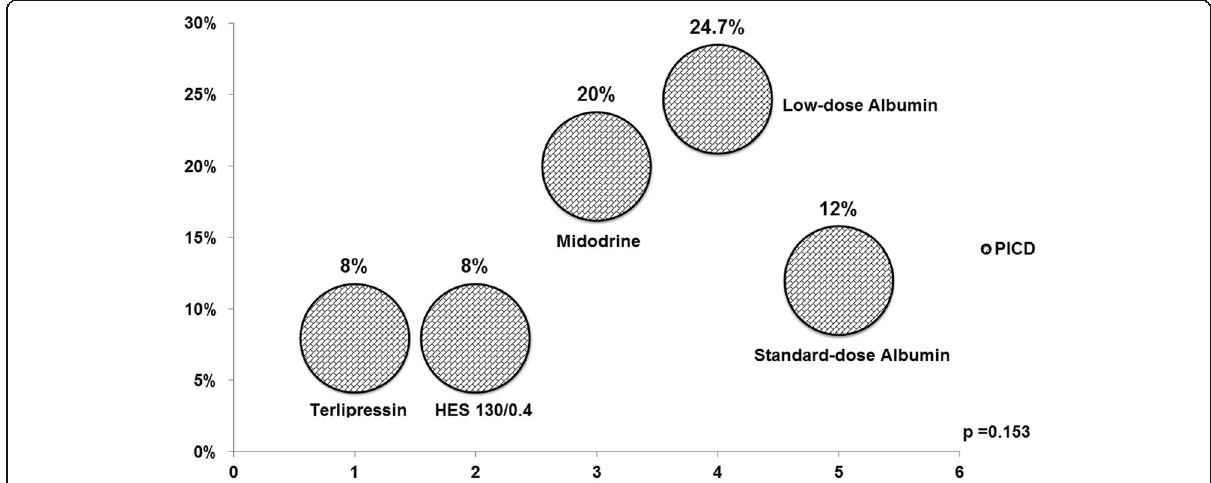
Fig. 3 Incidence of paracentesis circulatory dysfunction (PICD) in different groups, namely terlipressin, HES 130/0.4, midodrine, and low- and standard-dose